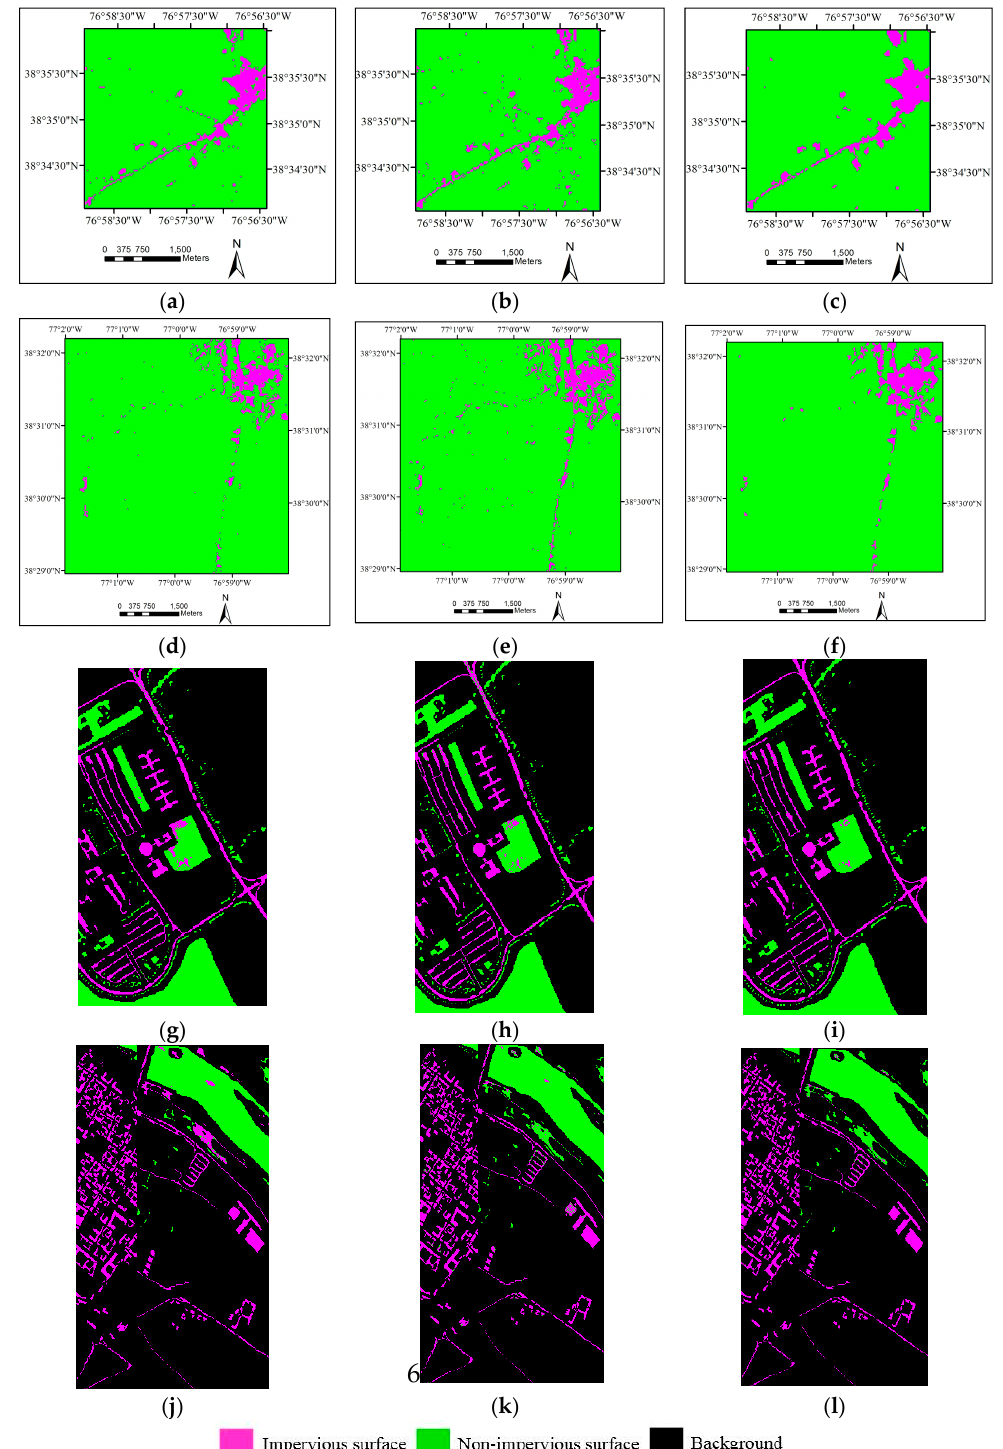
Figure 10. Classification images: ( a ) SPE-SVM; ( b ) SPE-RF; ( c ) SS-SR with post-classification refinement; ( d ) SPE-SVM; ( e ) SPE-RF; ( f ) SS-SR with post-classification refinement; ( g ) SPE-SVM; ( h ) SPE-RF; ( i ) SS-SR with post-classification refinement; ( j ) SPE-SVM; ( k ) SPE-RF; and ( l ) SS-SR with post-classification refinement.